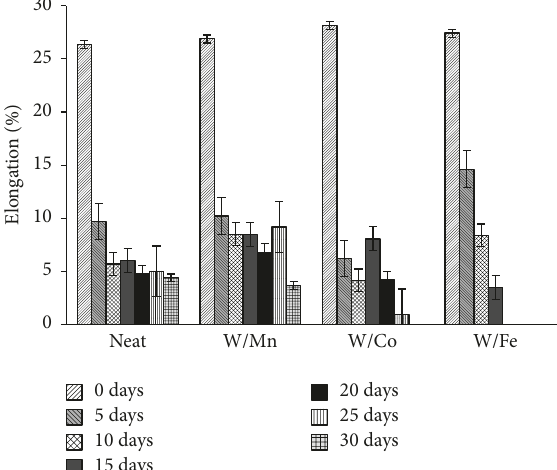
Figure 12: Elongation at break of Topas 8007 COC of neat and formulated films with different POA.